Question: Summarize what this figure shows in one sentence.
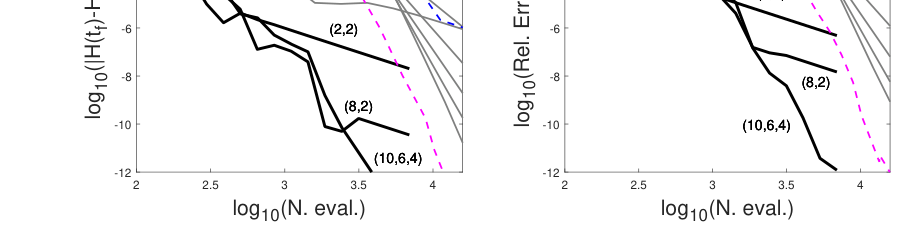
Answer: 1. Outer Solar System. Efficiency diagrams showing the relative error in energy (left panel) and in positions 𝑞(right panel) at the final time 𝑡𝑓= 2 · 105 days vs. the number of force evaluations, obtained with different schemes: extrapolation of order 𝑟= 2, 4, 6, 8, 10, 12 (grey curves), MATLAB routines ode23, ode45 and ode113, and splitting methods of generalized order (2,2), (8,2) and (10,6,4).